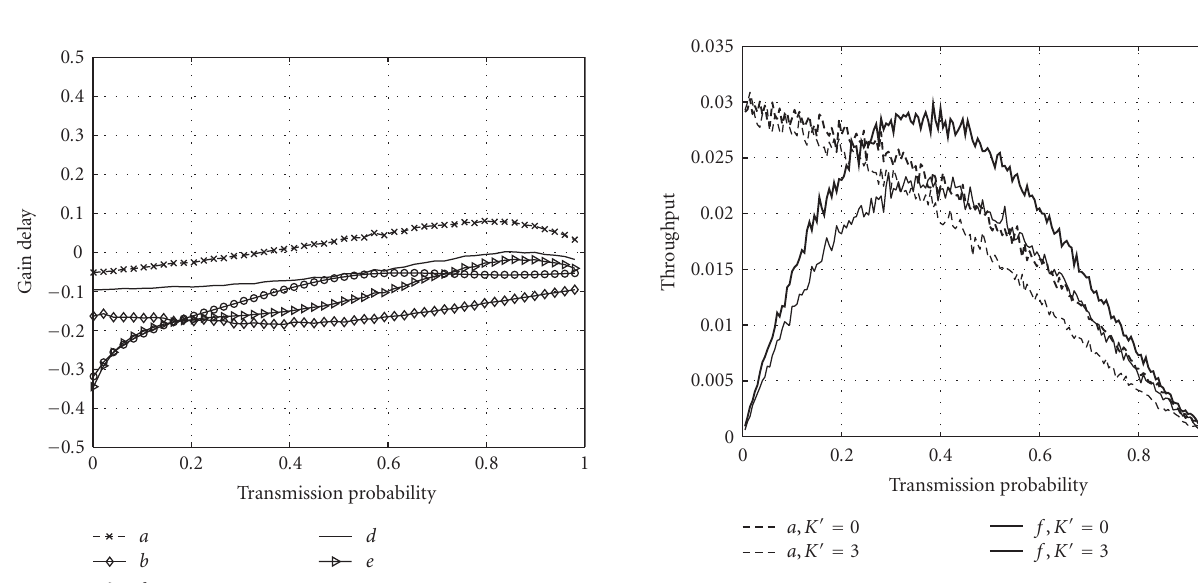
Figure 20: Throughput of the dynamic ( K (cid:5) = 3) and static ( K (cid:5) = 0) cases for K = 4 (asymmetric network of Figure